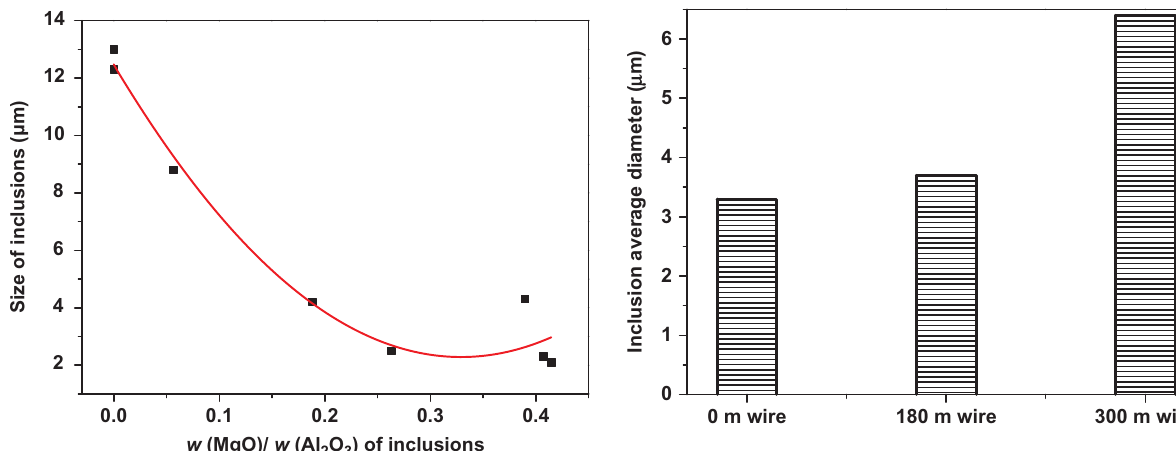
Figure 8: Inclusions size distribution in 95CrMo billets.